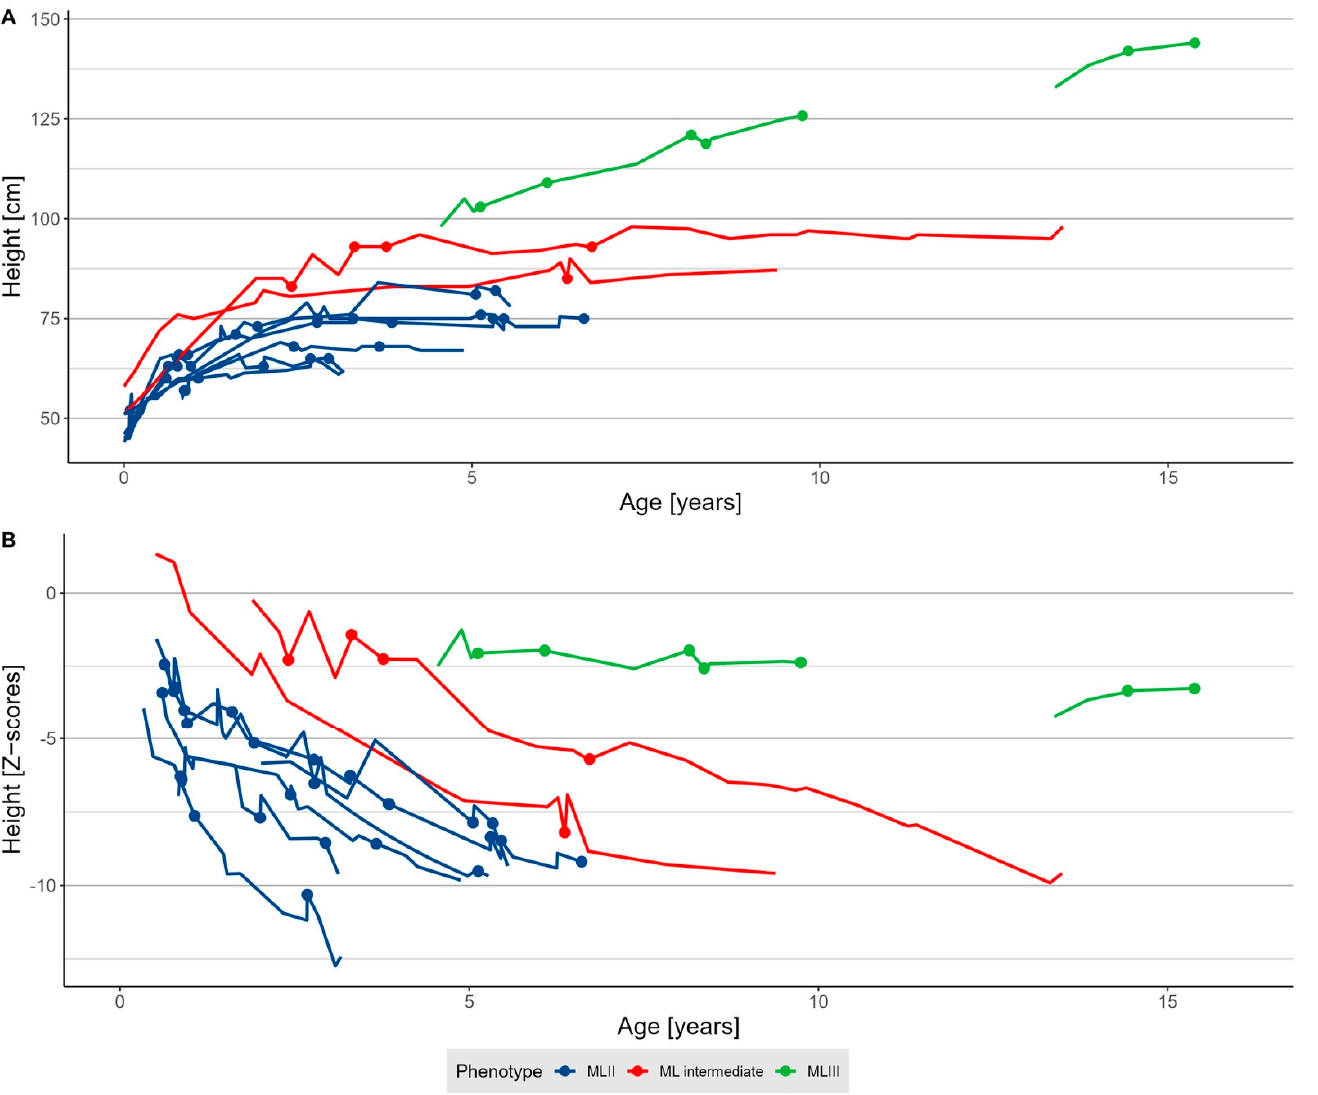
Figure 1. Growth in mucolipidosis. ( A ) Absolute height and ( B ) Z-scores [19] of patients with mucolipidosis type II (MLII, n = 7), intermediate (ML intermediate, n = 2), and III (MLIII, n = 3). Dots indicate the timepoints of anaesthesia procedures.